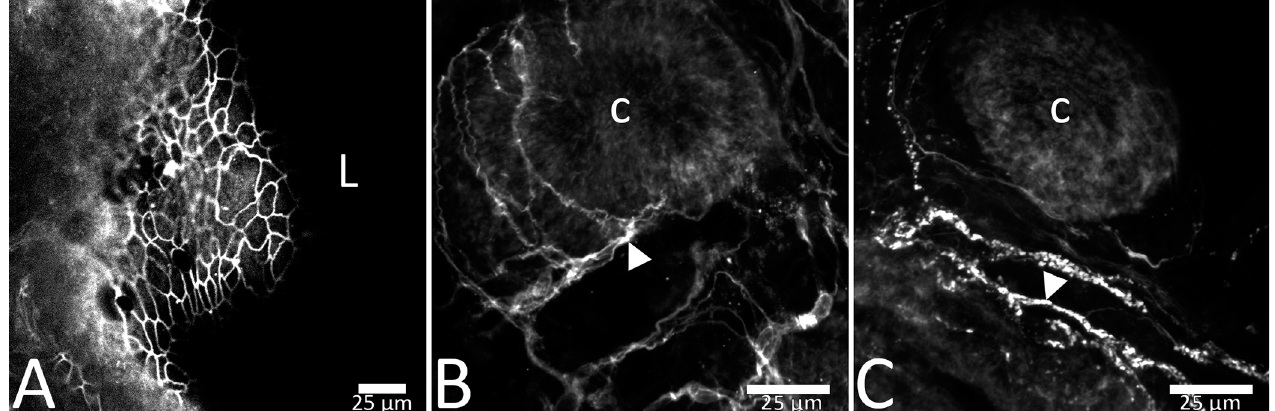
Fig 2. Barrier integrity was intact at 24 hours ex vivo, as assessed by the presence of tight junction protein ZO-1 at the apical mucosal surface (A). Neural components of lamina propria were present at 24h ex vivo. Representative images show S100 β -immunoreactivity at 24h ex vivo indicating enteric glial cells (B) and peripherin immunoreactivity indicating neuronal fibers ex vivo (C). Scale bars in panels A–C are 25 μ m. ‘L’ represents the luminal aspect and ‘c’ represents a colonic crypt. Arrowheads in panels B and C represent fibers with stereotypic